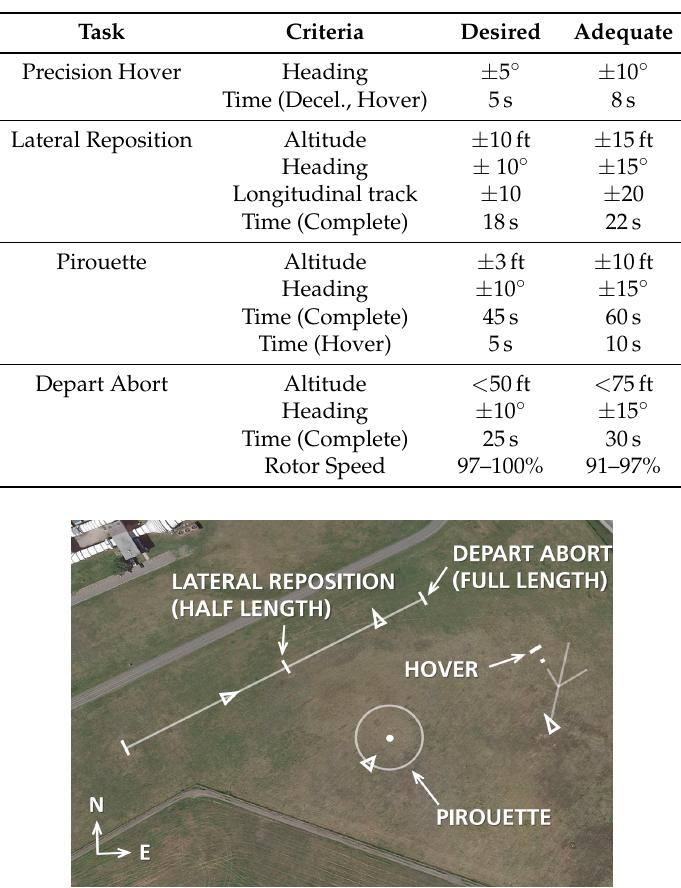
Table 1. Trial mission tasks and criteria, taken from [23].